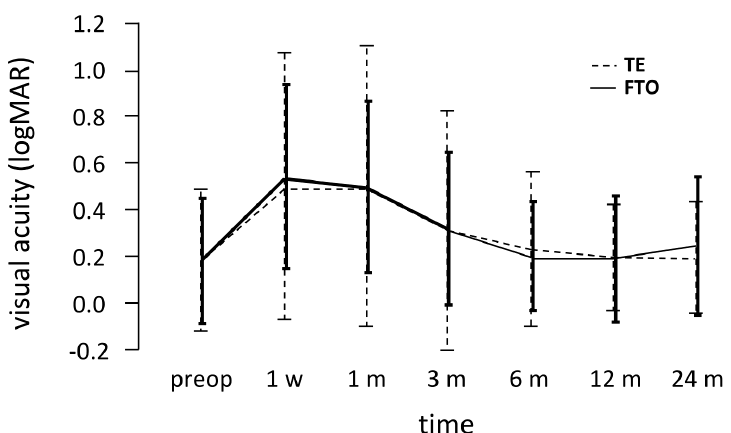
Figure 5. Scatter plots of visual acuity of both groups.